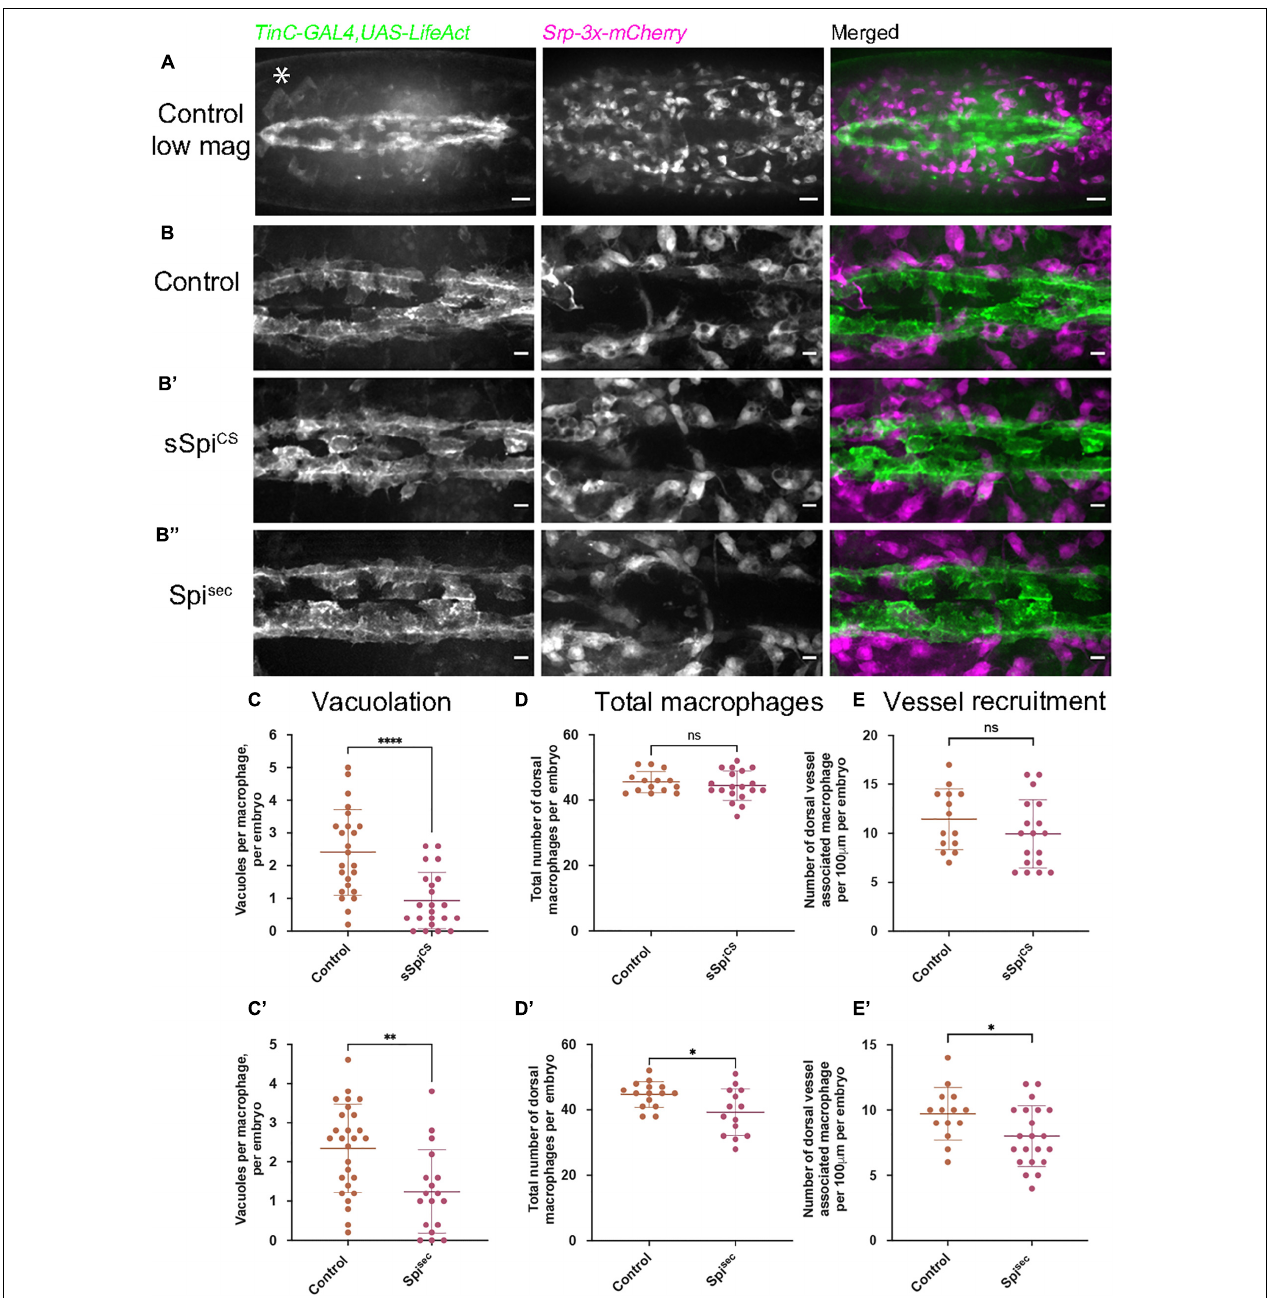
FIGURE 3 | Expression of Spitz in the developing fly heart alters macrophage localization and vacuolation. (A–B (cid:48)(cid:48) ) Maximum projections of dorsal side of stage 15 embryos showing the dorsal vessel (labeled using TinC-GAL4,UAS-LifeAct ; green in merge) and associated macrophages (labeled via Srp-3x-mCherry ) in controls (A,B) and embryos with TinC-GAL4 mediated expression of sSpitz CS (B (cid:48) ) or Spitz Sec (B (cid:48)(cid:48) ) . Anterior is right; asterisk ( ∗ ) denotes TinC-GAL4 driven expression in lateral regions away from the dorsal vessel. (C,C (cid:48) ) Scattergraphs of vacuole counts per macrophage in controls and in the presence of dorsal vessel-expressed sSpitz CS (C) ( n = 24, 22; p < 0.0001) or Spitz sec (C (cid:48) ) ( n = 27, 18; p = 0.0020). (D,D (cid:48) ) Scattergraphs of the total number of macrophages present in the field of view at the dorsal face in controls and in the presence of dorsal vessel-expressed sSpitz CS (D) ( n = 14, 19; p = 0.497) or Spitz sec (D (cid:48) ) ( n = 15, 14; p = 0.0170). (E,E (cid:48) ) Scattergraphs of the number of macrophages contacting the dorsal vessel in controls and in the presence of dorsal vessel-expressed sSpitz CS (E) ( n = 14, 18; p = 0.221) or Spitz sec (E (cid:48) ) ( n = 14, 21; p = 0.0312). Scale bars denote 20 µ m (A) and 10 µ m (B–B (cid:48)(cid:48) ) ; lines and error bars represent mean and standard deviation on scattergraphs, respectively; significance bars denote ns p > 0.05, ∗ p < 0.05, ∗∗ p < 0.01, ∗∗∗∗ p < 0.0001, respectively; statistical comparisons made via